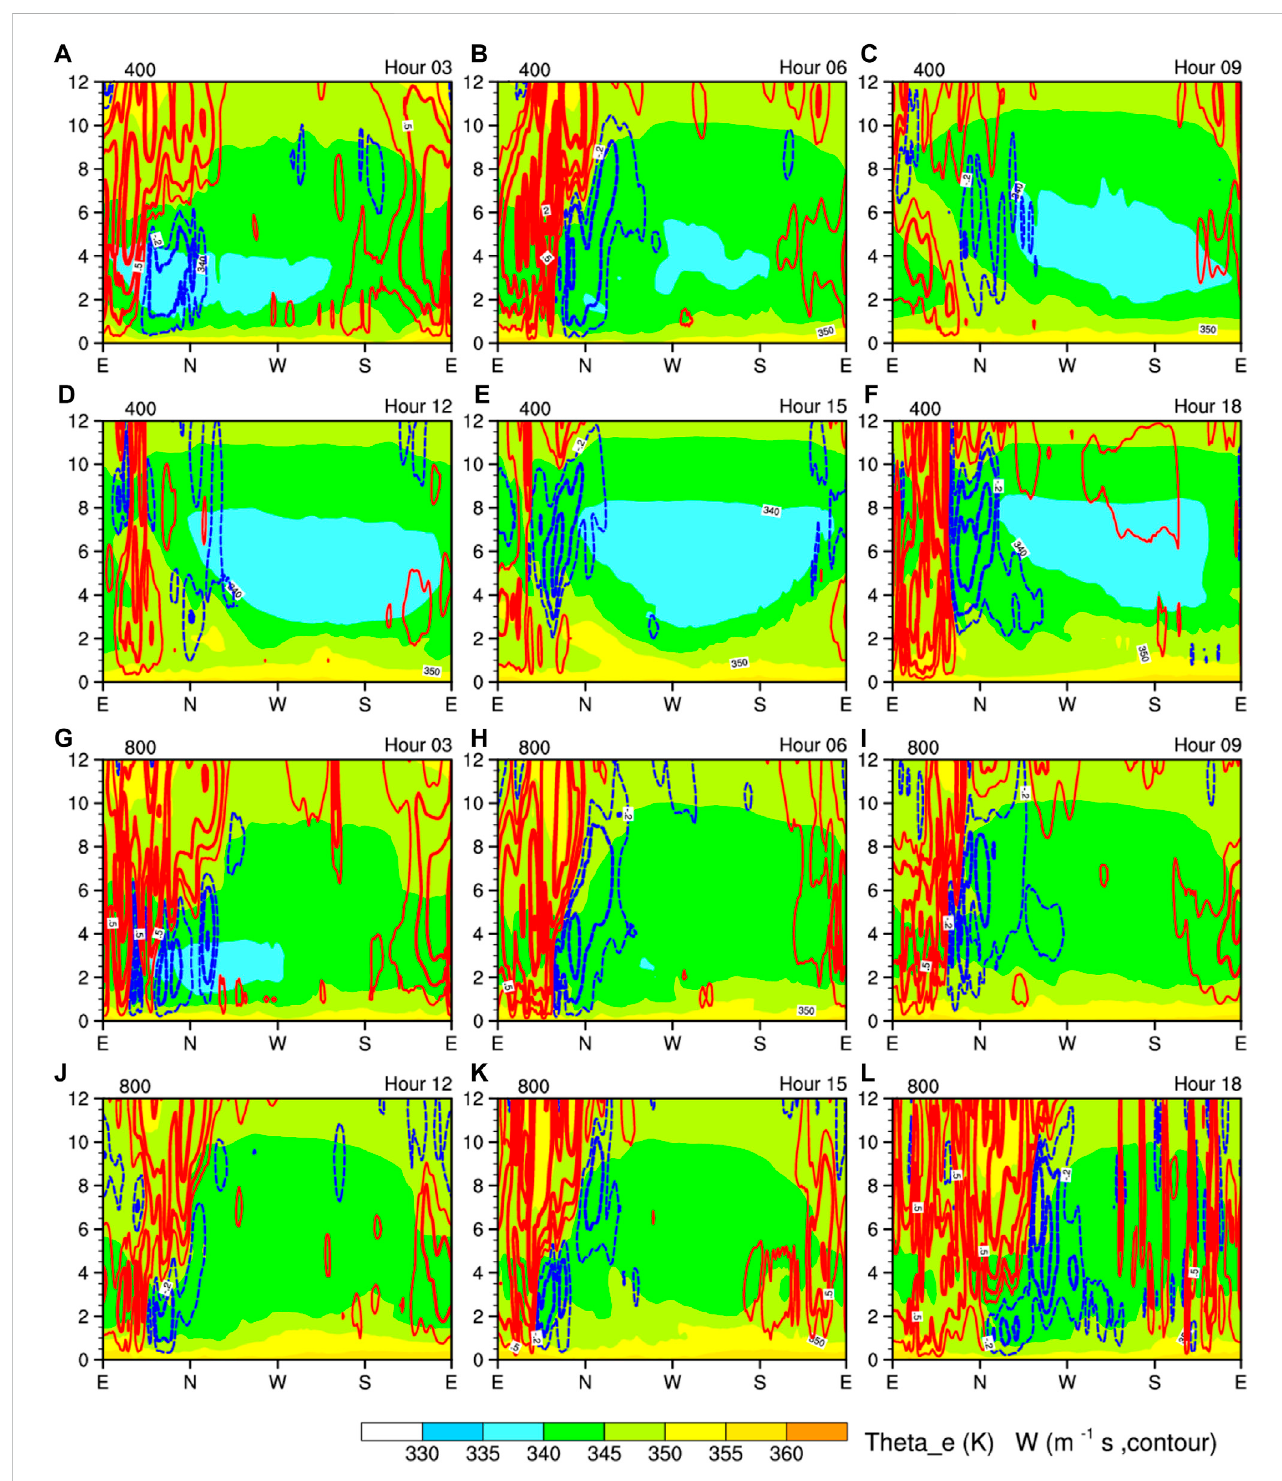
FIGURE 8 Vertical section of θ e (K, shaded) and vertical velocity (m s − 1 , contour) of ring-band average between radii at 30 – 80 km at hour 3, 6, 9, 12, 15, and 18. The contours are at -4, -2, -1, -0.5, -0.2, 0.2, 0.5, 1.0, 2, and 4 m s − 1 . The E, N, W, S on the X -axis indicate the east, north, west, and south directions, respectively. (A – F) Data from EXP400. (G – L) Data from